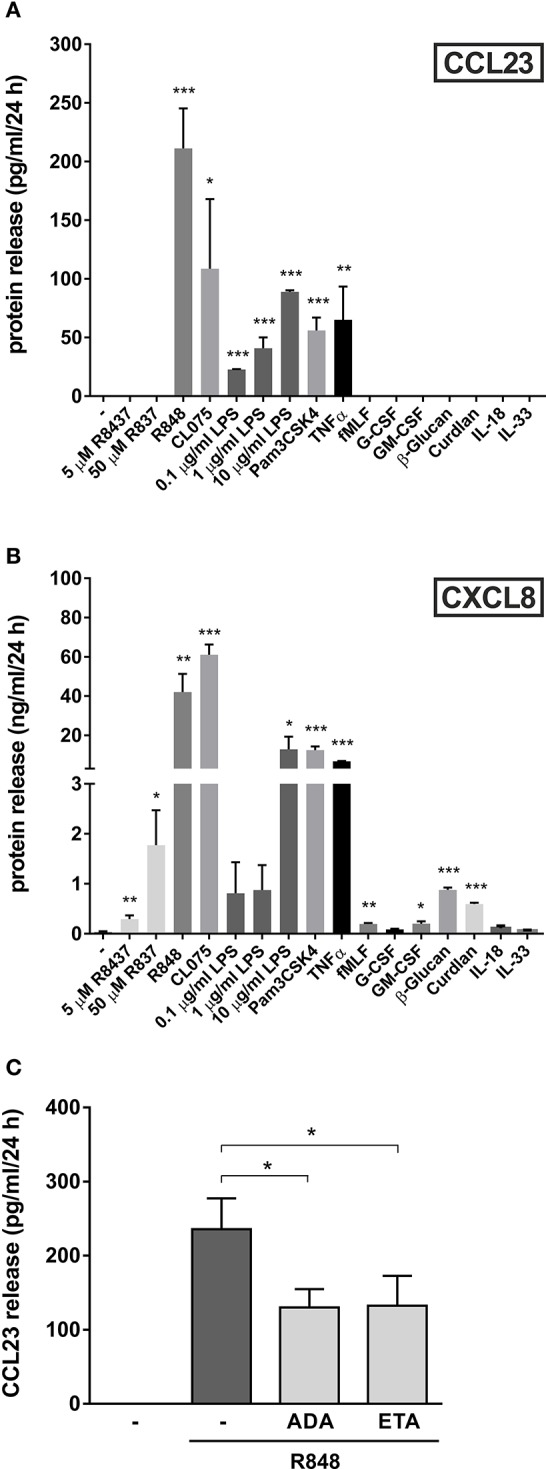
Other agonists, besides R848, trigger the production of CCL23 by human neutrophils. Neutrophils (5 × 106/ml) were cultured with or without 5–50 μM R837, 5 μM R848, 5 μM CL075, 0.1–10 μg/ml LPS, 1 μg/ml Pam3CSK4, 10 ng/ml TNFα, 10 nM fMLF, 10 ng/ml G-CSF, 10 ng/ml GM-CSF, 500 μg/ml β-Glucan, 500 μg/ml Curdlan, 100 ng/ml IL-18, and 100 ng/ml IL-33 for 24 h. Then, extracellular supernatants were collected to evaluate CCL23 (A) and CXCL8 (B) production by ELISA (mean ± SEM, n = 3–5). Asterisks stand for significant increases as compared to untreated cells: *P < 0.05, **P < 0.01, ***P < 0.001, by Student's t-test. (C) Neutrophils (5 × 106/ml) were pretreated for 30 min with 10 μg/ml adalimumab (ADA) or 10 μg/ml etanercept (ETA), to be subsequently incubated for further 24 h with 5 μM R848. Cell-free supernatants were then collected to evaluate CCL23 production by ELISA (mean ± SEM, n = 3–5). Asterisks stand for significant inhibition: *P < 0.05, by one-way ANOVA followed by Tukey's post-test.